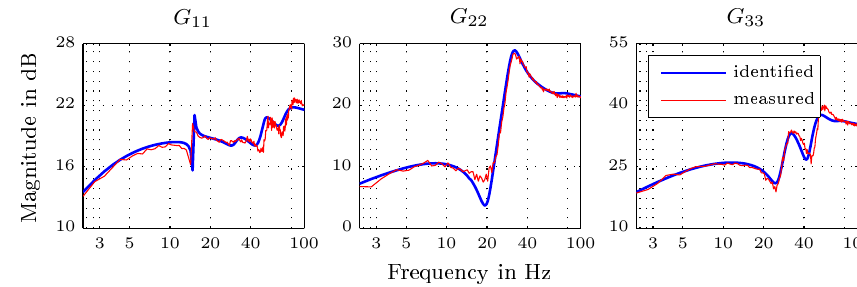
Figure 8. Comparison of the measured non-parametric FRM ˆ G [ qP 2 ] and the identified parametric one G [ qP 2 ]